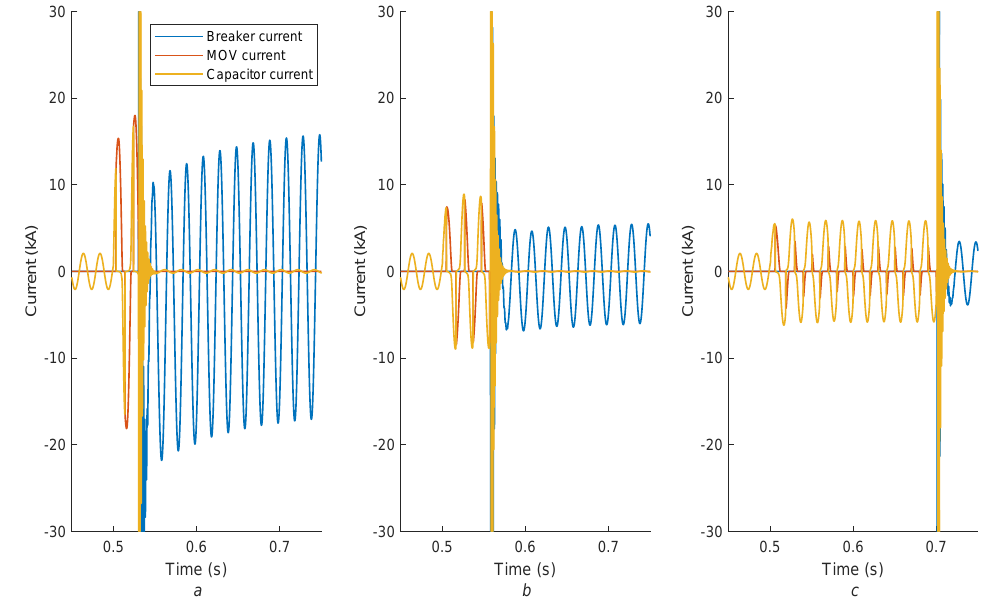
Figure 7. Currentsin capacitor, MOV and circuit breaker for ( a ) high current, ( b ) moderate current and ( c ) low current